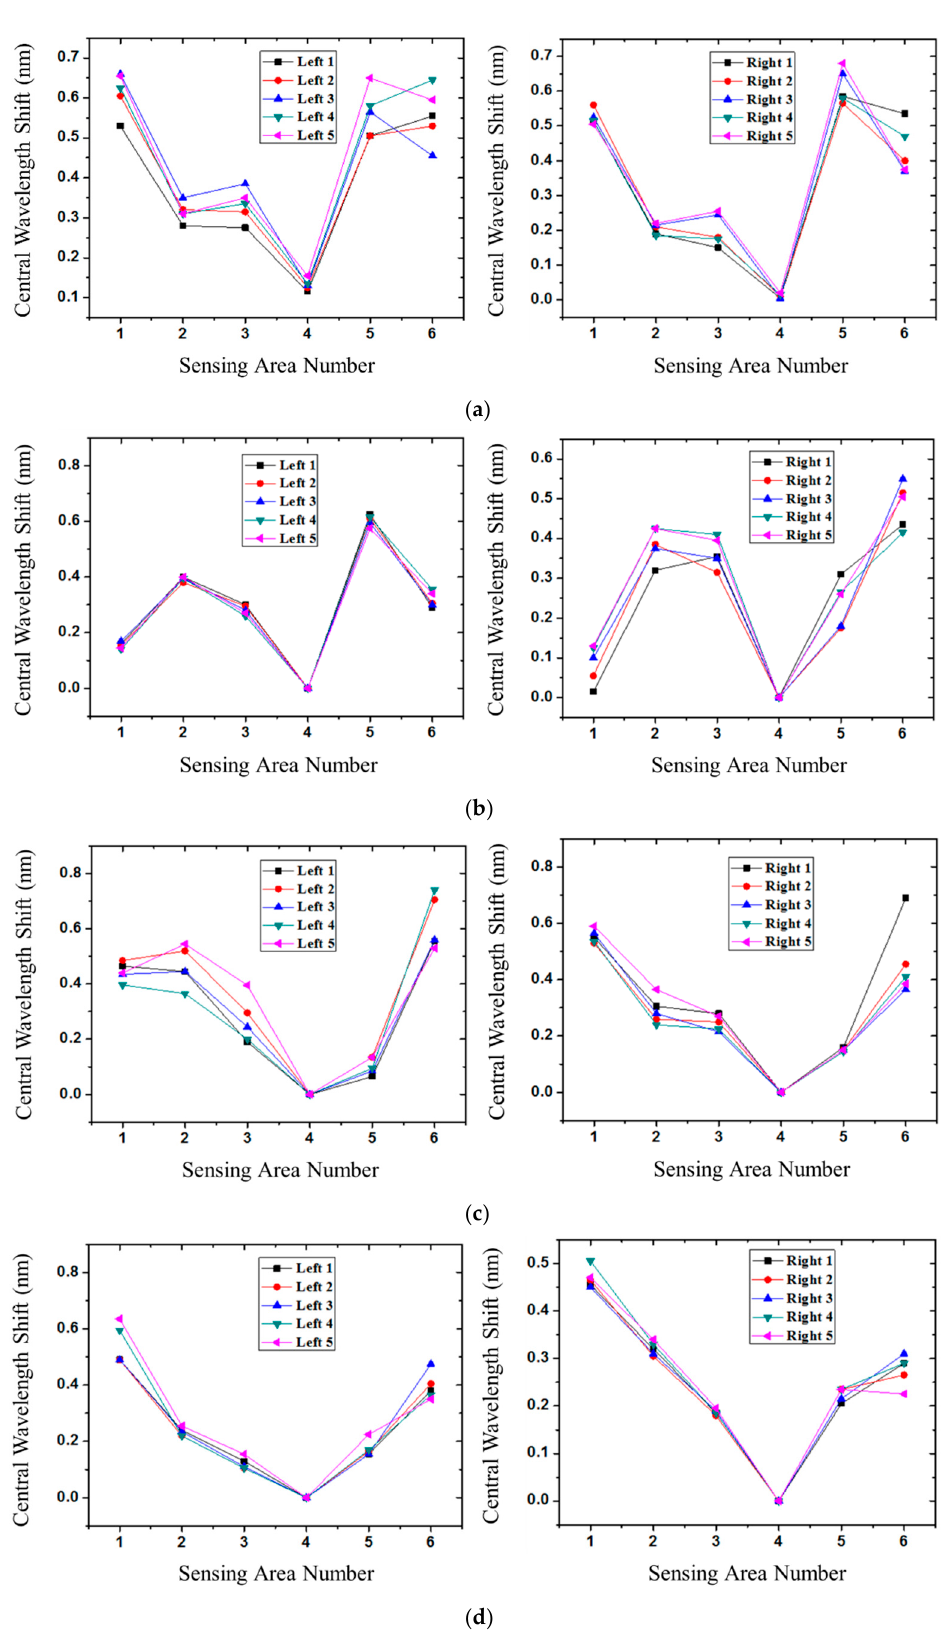
Figure 12. The central wavelength shift as a function of sensing area number for plantar pressure distribution of left and right foot: ( a ) Flat feet; ( b ) supinated feet; ( c ) cavus feet; and ( d ) neutral feet.